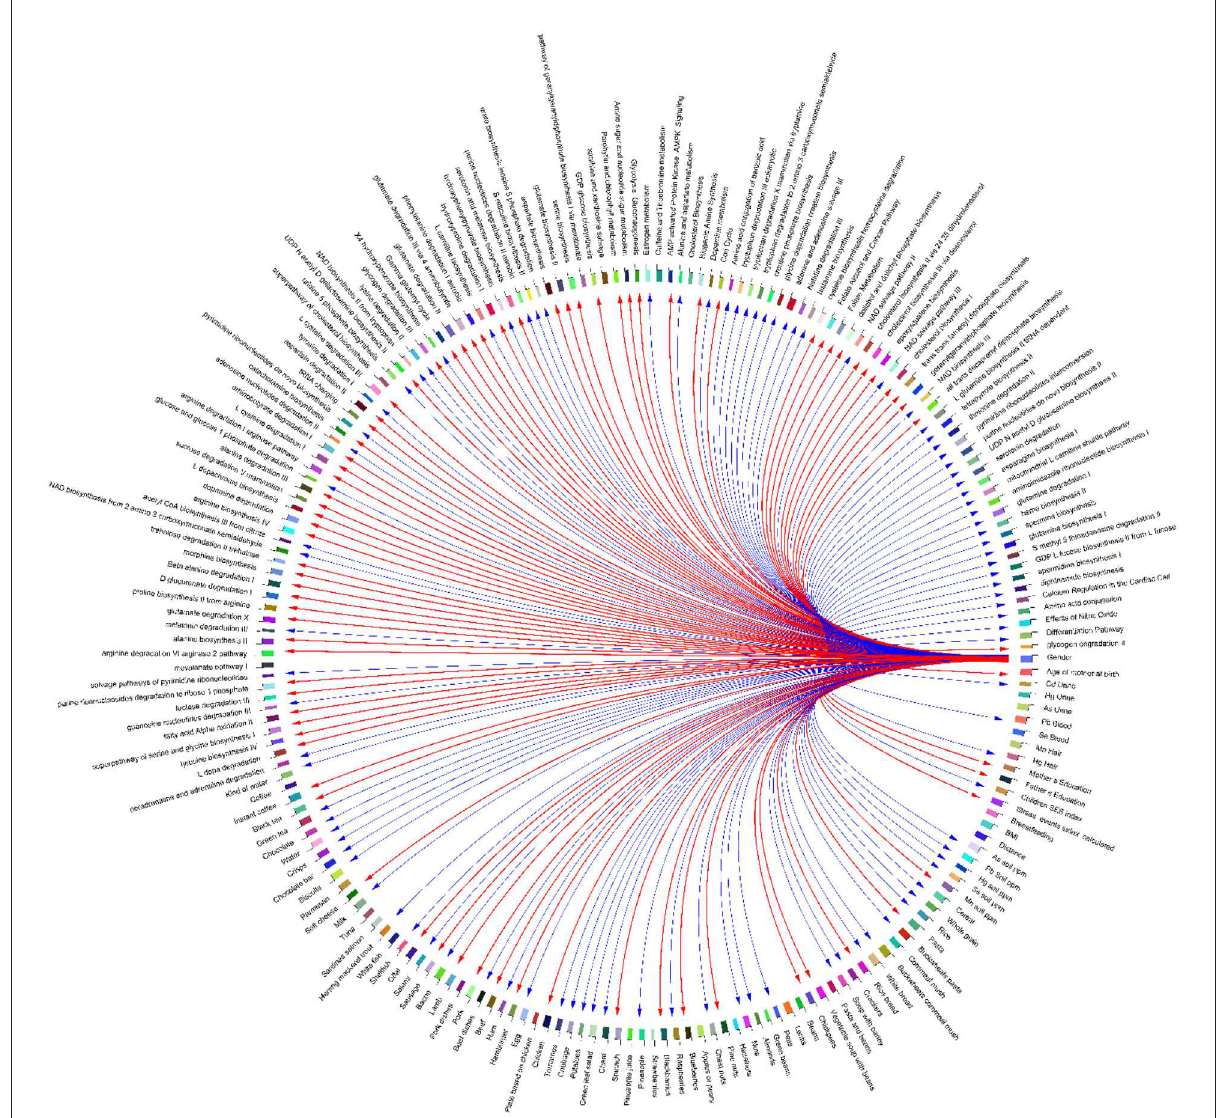
FIGURE11 Correlation globe of exposure factors and detected metabolic pathways in HERACLES cohort participants. Based on the results metabolic pathways related to amino acids metabolism and urea cycle found to be highly associated with the concentrations of heavy metals in biological samples. For example, the biosynthesis of L-tyrosine found to be significantly correlated with the concentrations of Pb ( p -value = 0.04), Mn ( p -value = 0.02), and Hg ( p -value = 0.03). The biosynthesis of NAD from tryptophan, and the synthesis of acetyl-CoA from citrate are highly correlated with the Pb concentrations ( p -value = 0.02). Also, the metabolism of the neurotransmitter dopamine is correlated with the concentrations of Pb ( p -value = 0.02), and Hg ( p -value = 0.01). The correlations between the detected pathways related to amino acids metabolism and urea cycle and the concentrations of metals, indicate imbalance between the cellular reactive oxygen species (ROS), which may be an effect of exposure to metals, and the inability of the cell to detoxify them, leading to oxidative